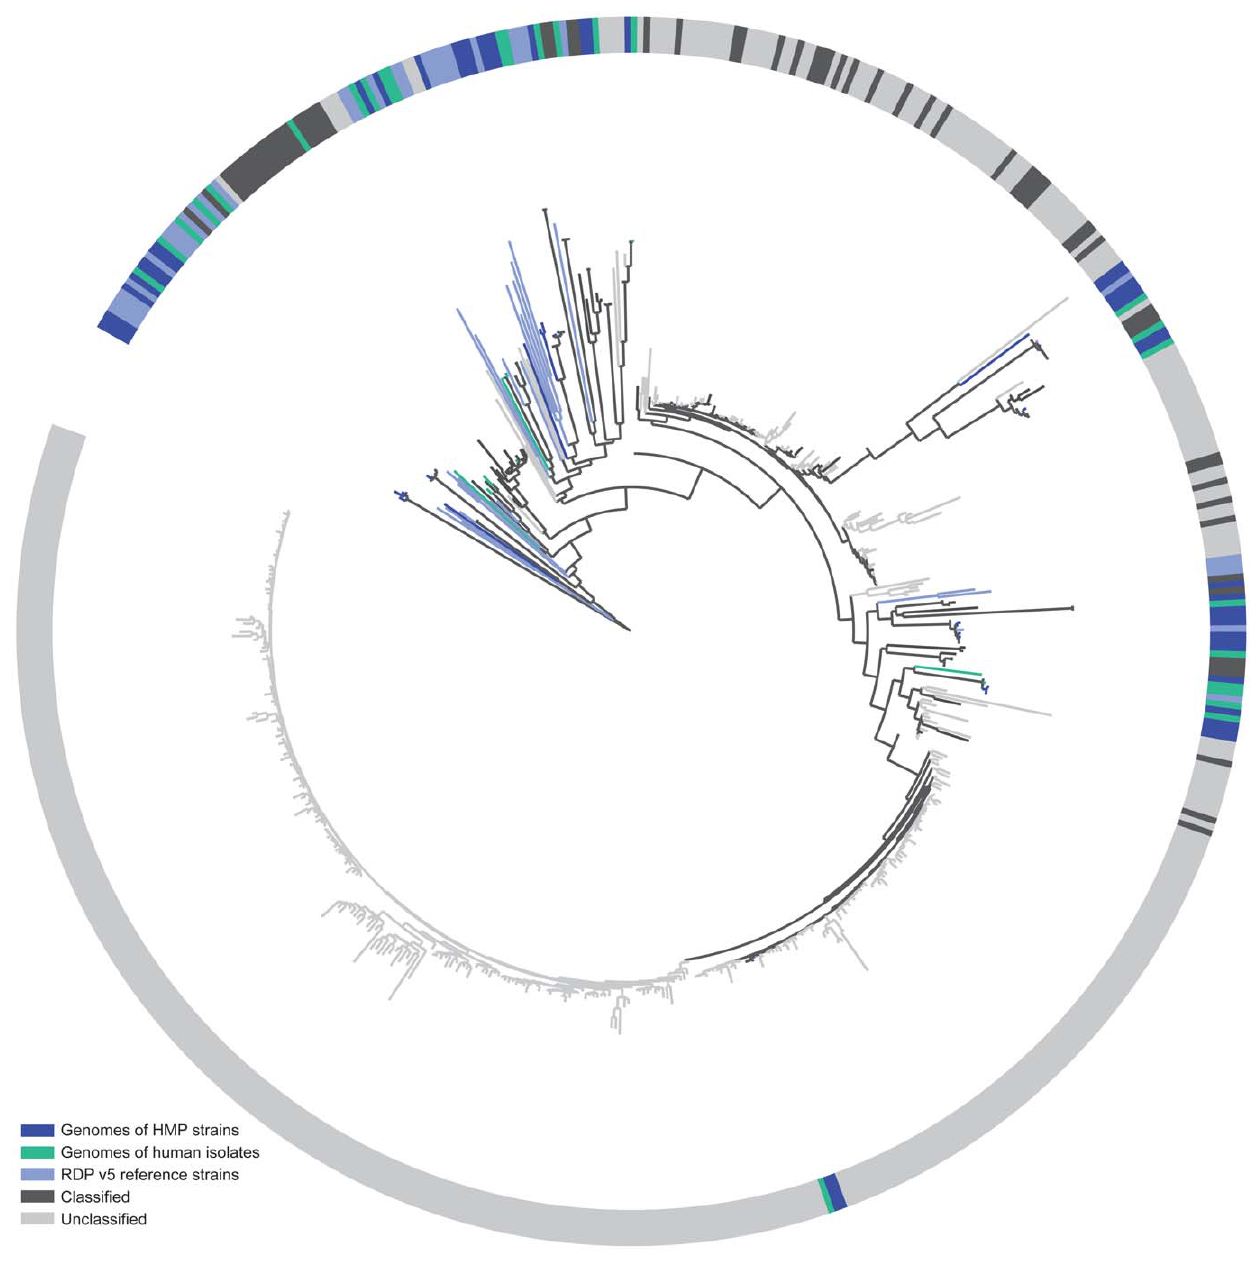
Figure 9. The Lachnospiraceae 16S diversity observed in stool samples is greater than from known reference resources. A phylogenetic tree constructed with 16S sequences from RDP’s training set (light blue, n=34), publicly available genomes from human isolates (green, n=26), publicly available HMP genomes (dark blue, n=44), and sequences from aggregate stool samples that could be classified at the genus level (dark grey, n=63) and that remained unclassified at the genus level (light grey, n=408).